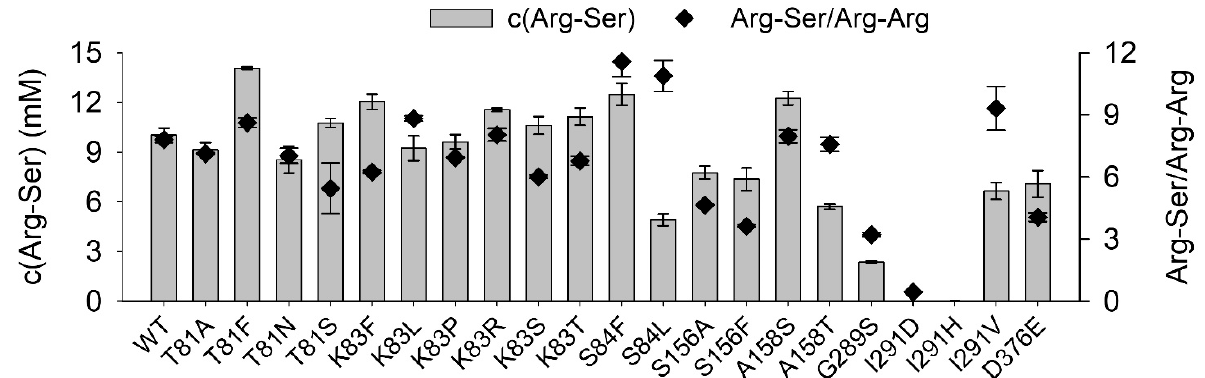
Figure 6. Formation of Arg-Ser and Arg-Arg by the RizA variants. 30 mM of both arginine and serine and 20 h reaction time at 25 °C. Reactions were set up in triplicates and data is presented as mean ± standard deviation.